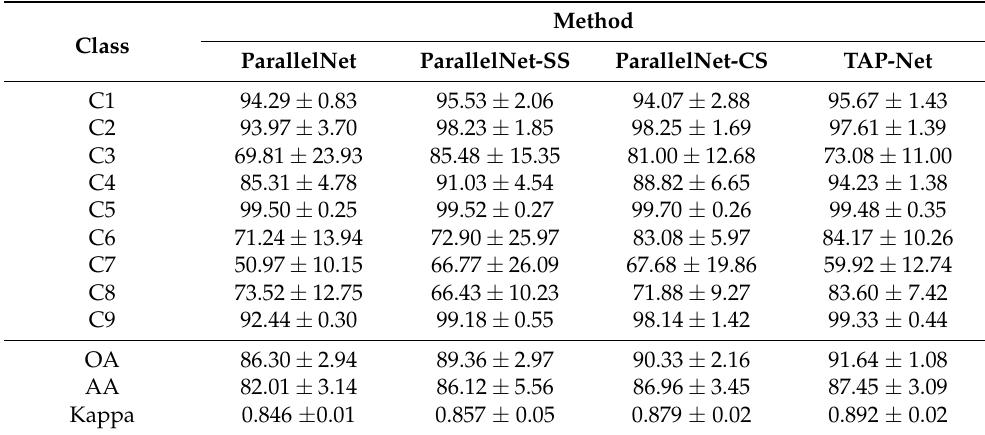
Table 9. Comparison between different attention mechanisms over Pavia University dataset in terms of Per-class, overall (OA), average (AA) accuracy (in %) and the Kappa